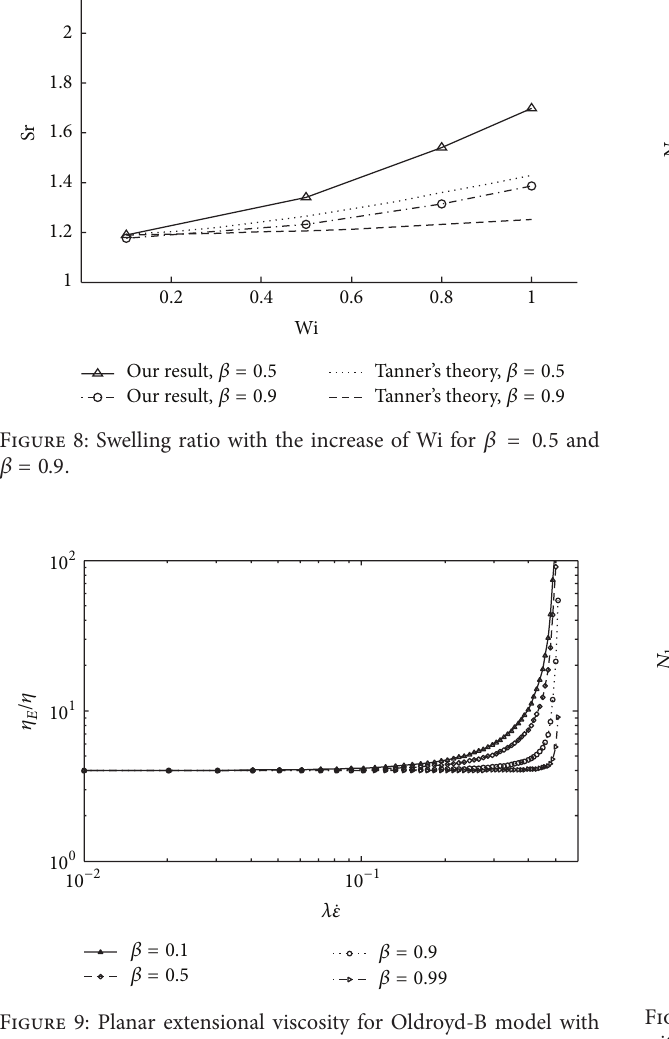
Figure 9: Planar extensional viscosity for Oldroyd-B model with various 𝛽 .